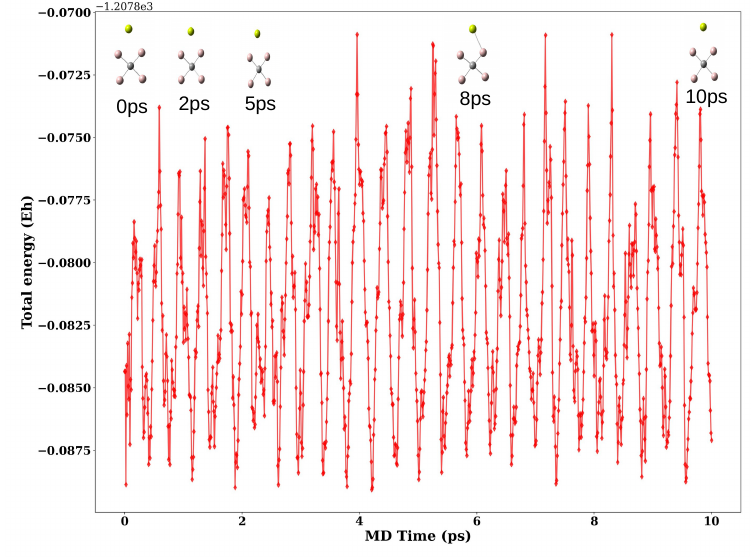
− ( 1a ) at 298 K in 10 ps ab initio MD simulations calculated 4 Mg